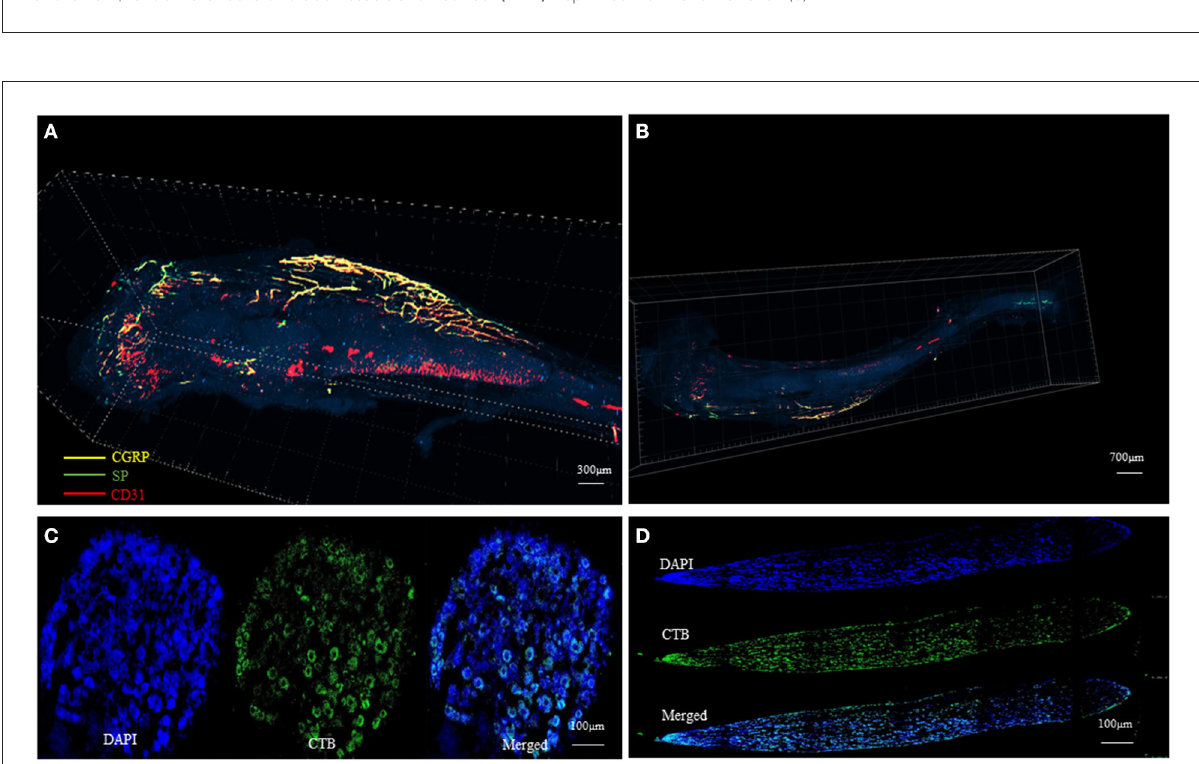
FIGURE2 Distribution of the nerves within the periosteum, bone, and bone marrow. (A) Scheme of the nerves within the bone. There are mainly two types of nerves: sensory nerves and sympathetic nerves. (B–D) Representative images of the nerve fibers distributed in the periosteum (B) , cortical bone (C) , and bone marrow (D) . By immunofluorescence staining, TH + sympathetic fibers showed yellow color, CGRP + fibers showed green, and CD31 + endothelial cells of blood vessels showed red. (B–D) Reprinted from Chartier et al. (8).